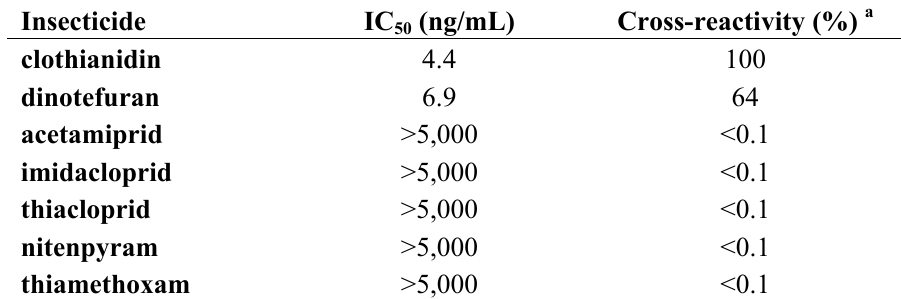
Table 1. Cross-reactivity of MoAb CTN-16A3-13 with neonicotinoid insecticides in the